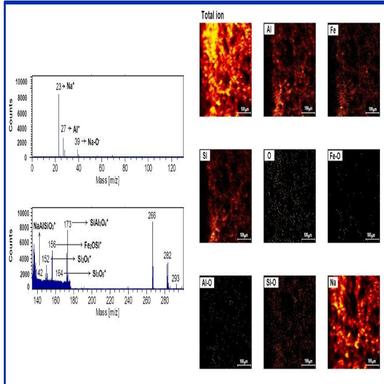
ToF-SIMS positive ion mass fragments of geopolymer coating material on mild steel with molecular imaging acquired at the coating-Fe interface. (All images at 100 μm).